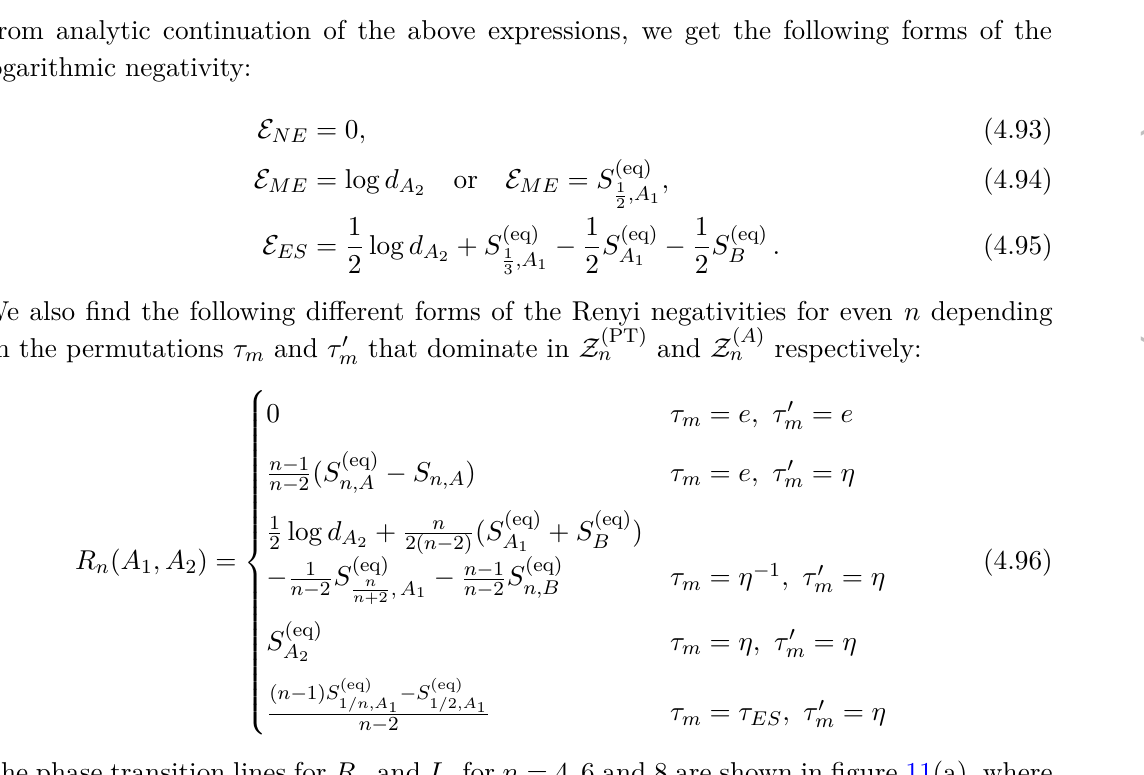
Figure 11 . (a) shows the phases of E with I α as in (4.87), s ( (cid:15) ) = phase transitions of the mutual information are shown with dashed black lines. In (b), we show the same phase transition lines of E alongside the phase transition lines of Z (PT)